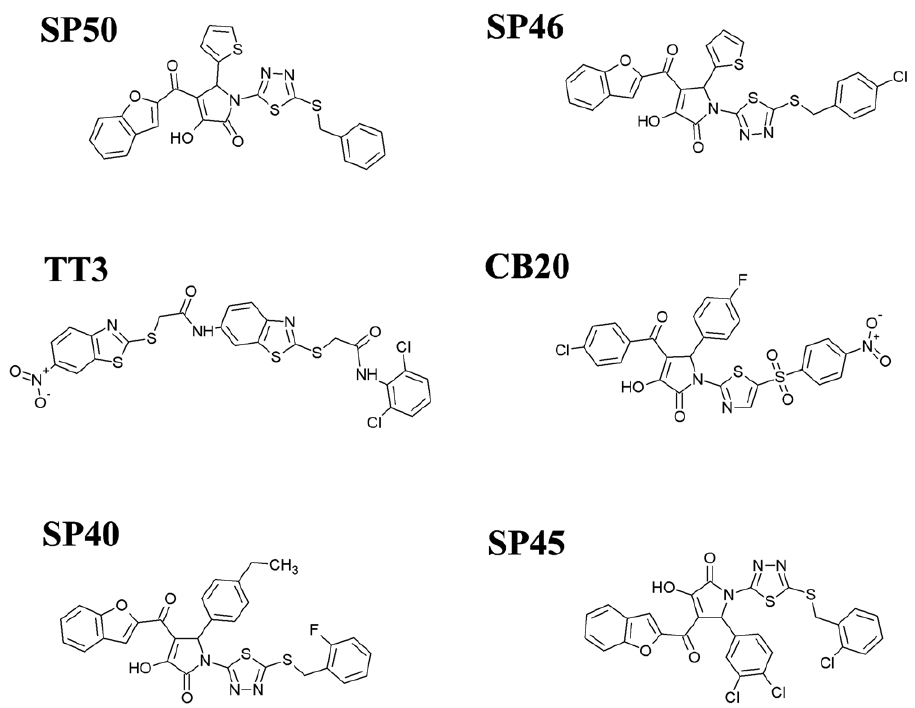
Figure 5. The conventional 2D representation of the six selected ligands showing inhibitory properties for CCR4-mediated migration.